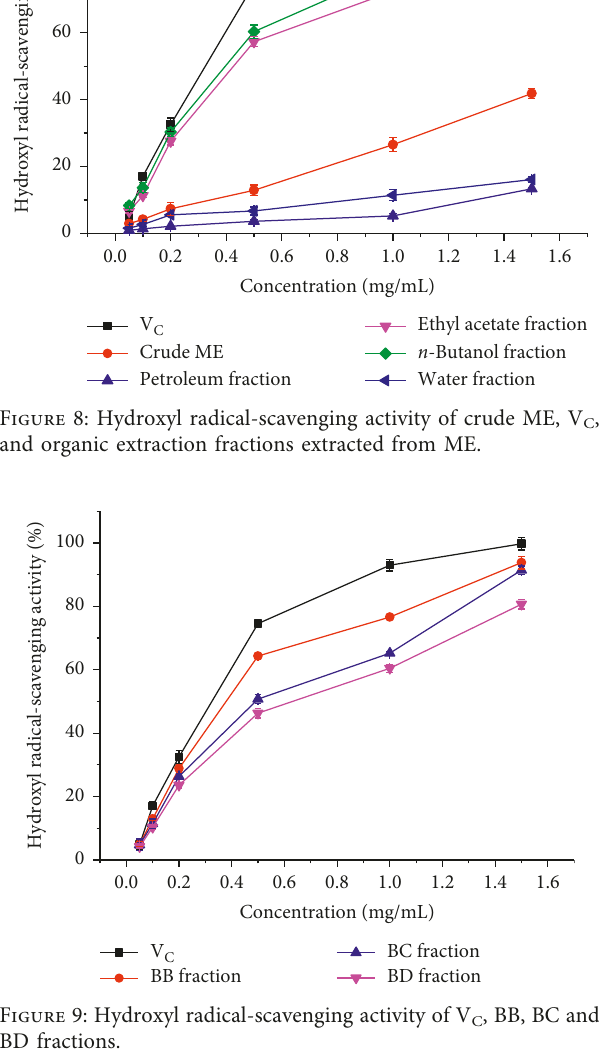
Figure 7: ABTS-scavenging activity of compound H and V